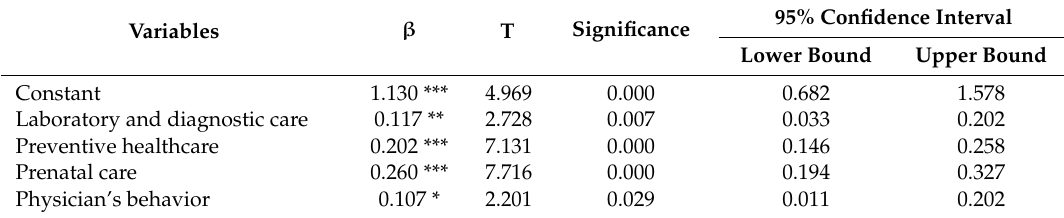
Table 3. Multiple